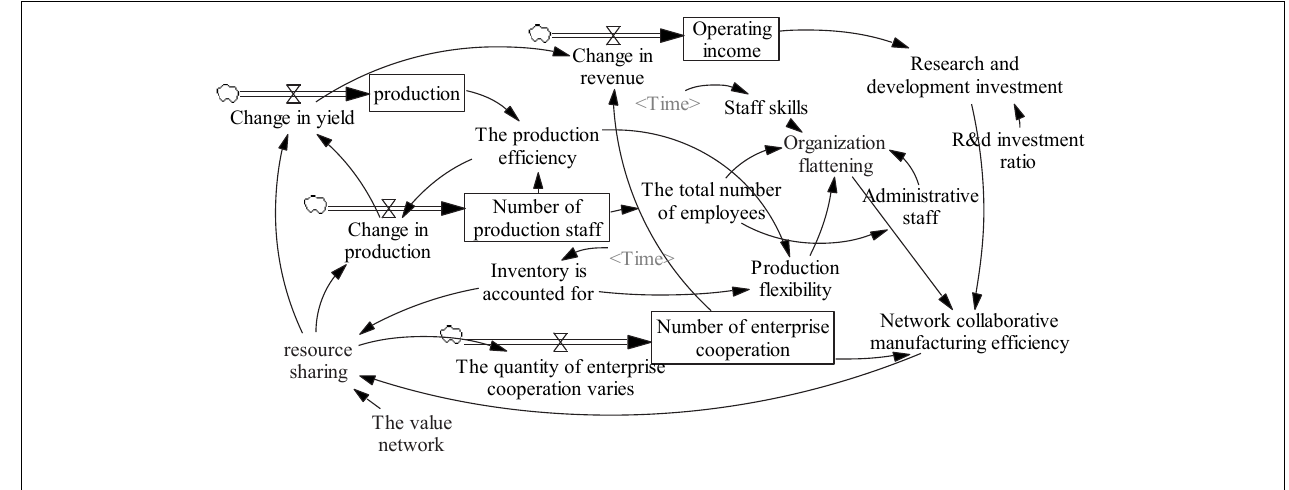
FIGURE 5 | Internal enterprise flow